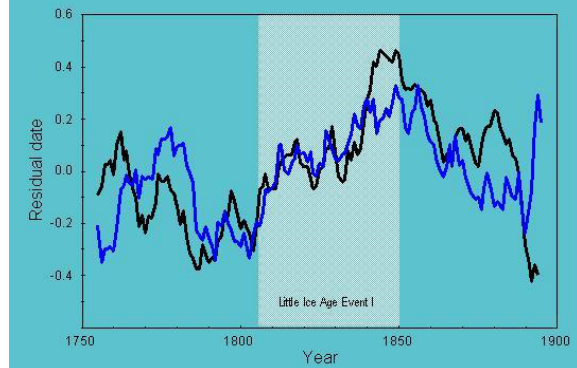
Fig. 6. Verification of the habitat phenology in the retrospective model against independent data on spring phenology 1750–1900. Blue line: modelled average laying date of great tits. Black line: index of spring phenology according to Rutishauser et al. (2007). Both indices are given as the standardized residual deviation from the long-term (1750–1900) average laying date and spring index,